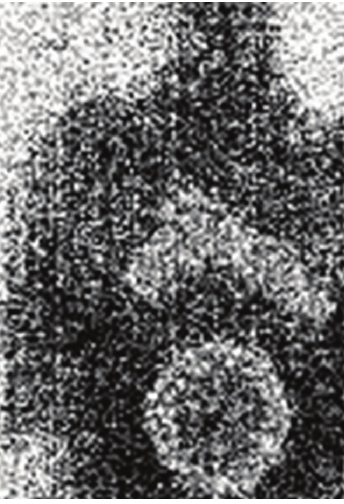
Figure 2: The radiometric image of the concealed objects on a per-